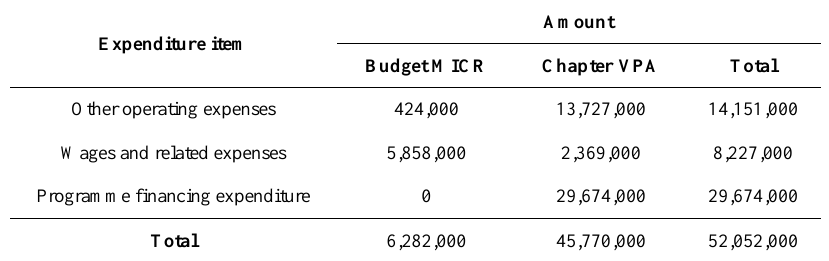
Table 2. FRSCR expenditures in connection with the Vrbětice emergency in 2014–2019 (in thousands of CZK) Expenditure